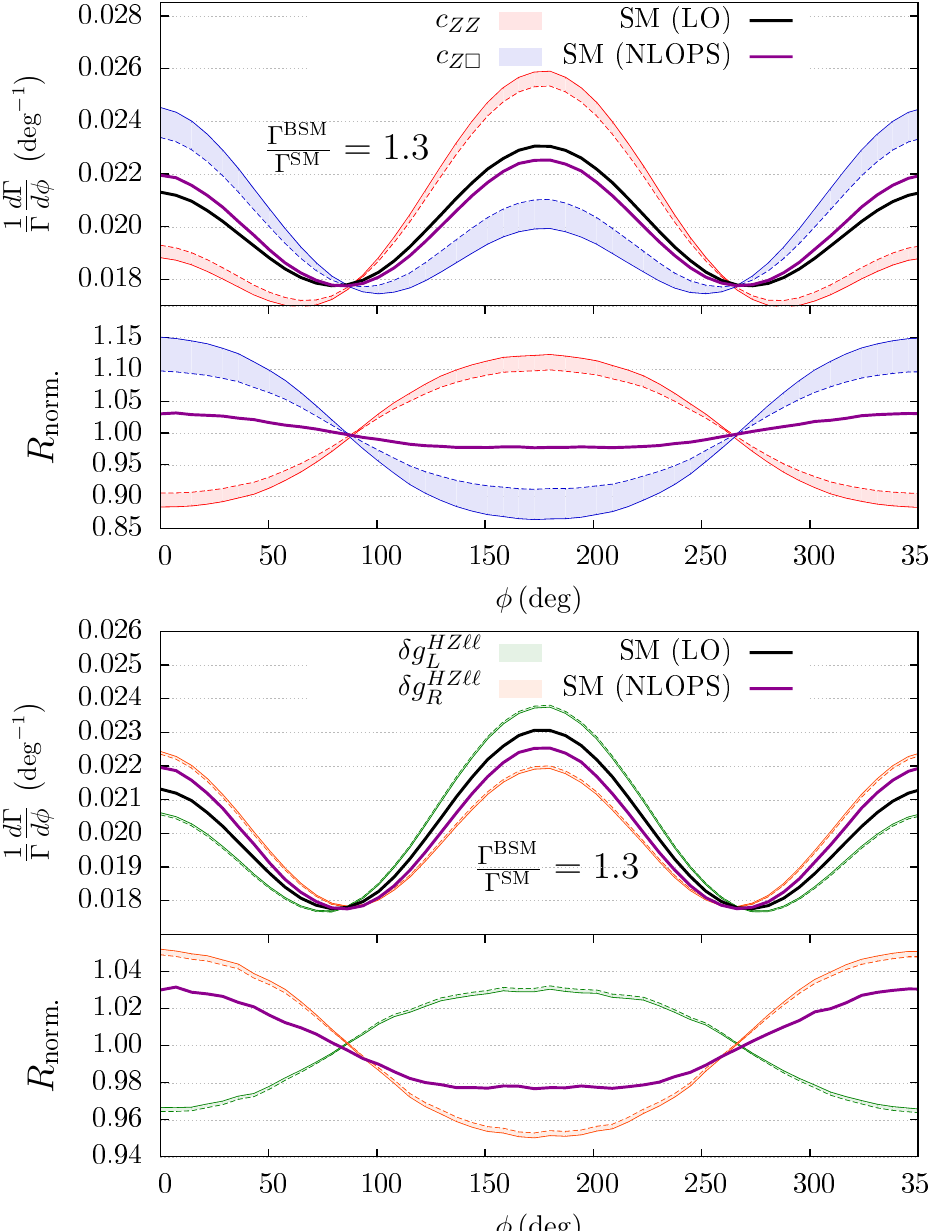
Figure 3. Upper panels: normalized distributions for (cid:30) at LO (black curve), at NLOPS EW accuracy (violet curve) and for values of c ZZ (red curves), c Z (cid:3) (blue curves), (cid:14)g HZ‘‘ giving rise to a ratio R BSM = 1 : 3. Lower panels: normalized ratios, according to the de(cid:12)nitions in eq. (4.2). Solid lines refer to pure 1 = (cid:3) 2 e(cid:11)ects, for dashed lines quadratic contributions are also included. The shaded bands between solid and dashed lines highlight the shape variations induced by the inclusion of quadratic